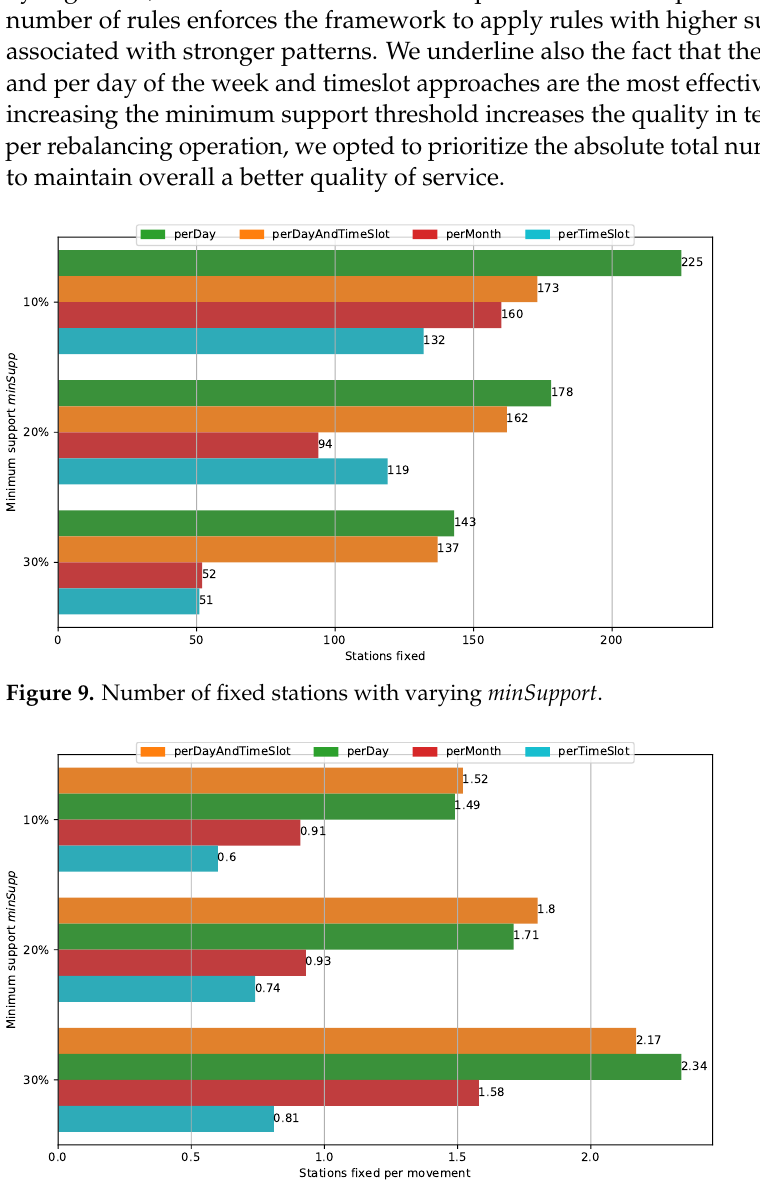
Figure 10. Number of fixed stations per bike movement with varying minSupport